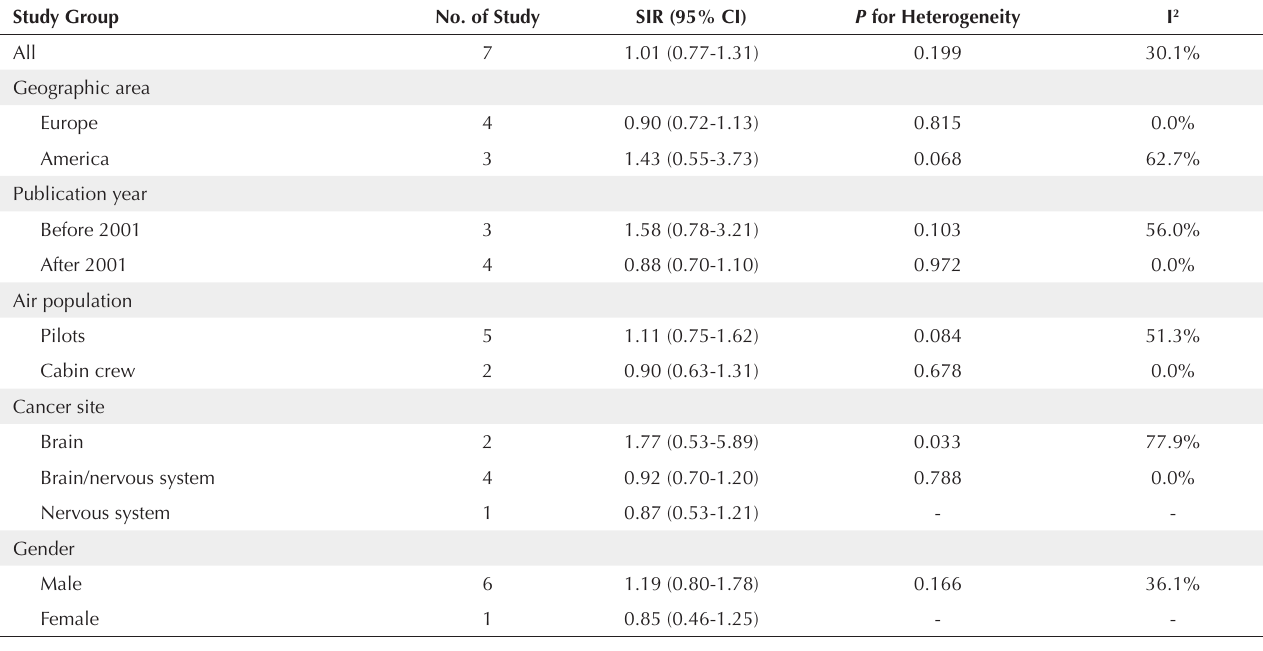
Table 2. Subgroup Analysis of the SIR of BNSC in Aircrew Compared With the General Population Study